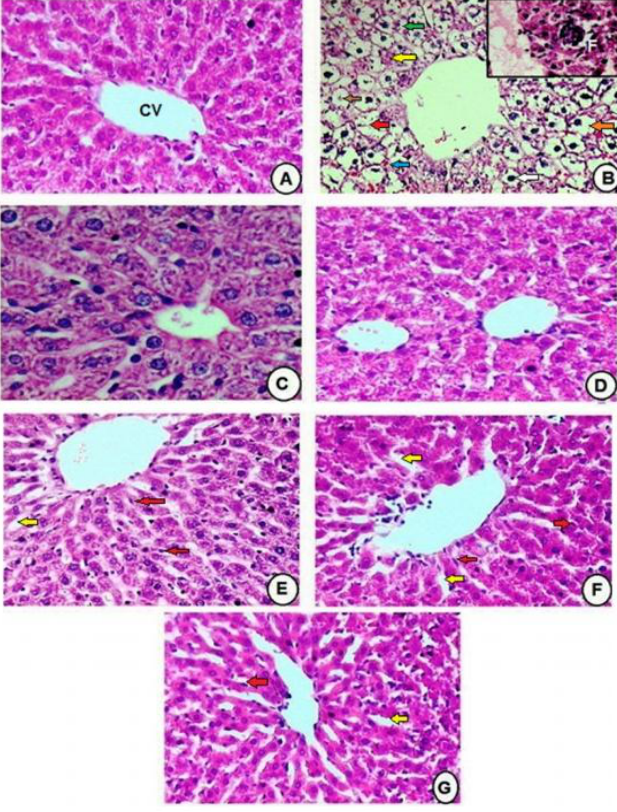
Figure 8: Neem leaves extract protects liver from cisplatin-induced injure. A; control liver section with the normal architecture of hepatic lobule. The central vein (CV) lies at the center of the lobule surrounded by cords of hepatocyte. B; rats treated with cisplatin shows loss of hepatic tissue structural pattern and hydropic degeneration ( ) in the hepatocytes, granulated cytoplasm( ), the pyknotic nuclei( ), Karyorrhexis ( ), Karyolysis ( ), pale stained nuclei ( ), congested blood sinusoid ( ) and focal necrosis associated with lymphocytic infiltration (f). C and D; rats treated with neem leaves extract for 5 and 10 days, respectively. E, F and G; rats treated with a single dose of cisplatin followed by a daily dose of neem leaves extract for 5 days, neem leaves extract for 5 days before injection of a single dose of cisplatin and neem leaves extract for 5 days before and after injection of a single dose of cisplatin, respectively, showing the nearly normal polyhedral hepatocyte, the dilated blood sinusoids ( ) and activated Von Kupffer cell ( ) (H & E X 200)